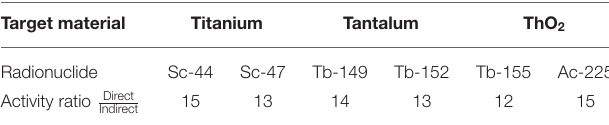
TABLE 2 | Predicted activity gains from a direct irradiation in comparison to the indirect